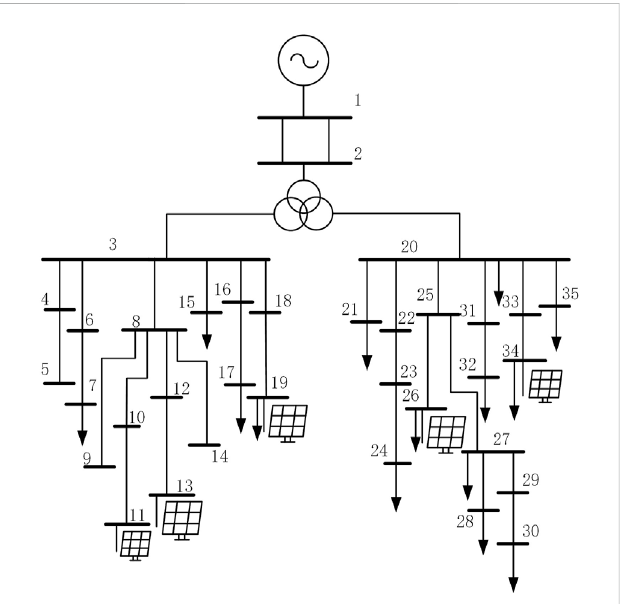
A 35-node distribution network.